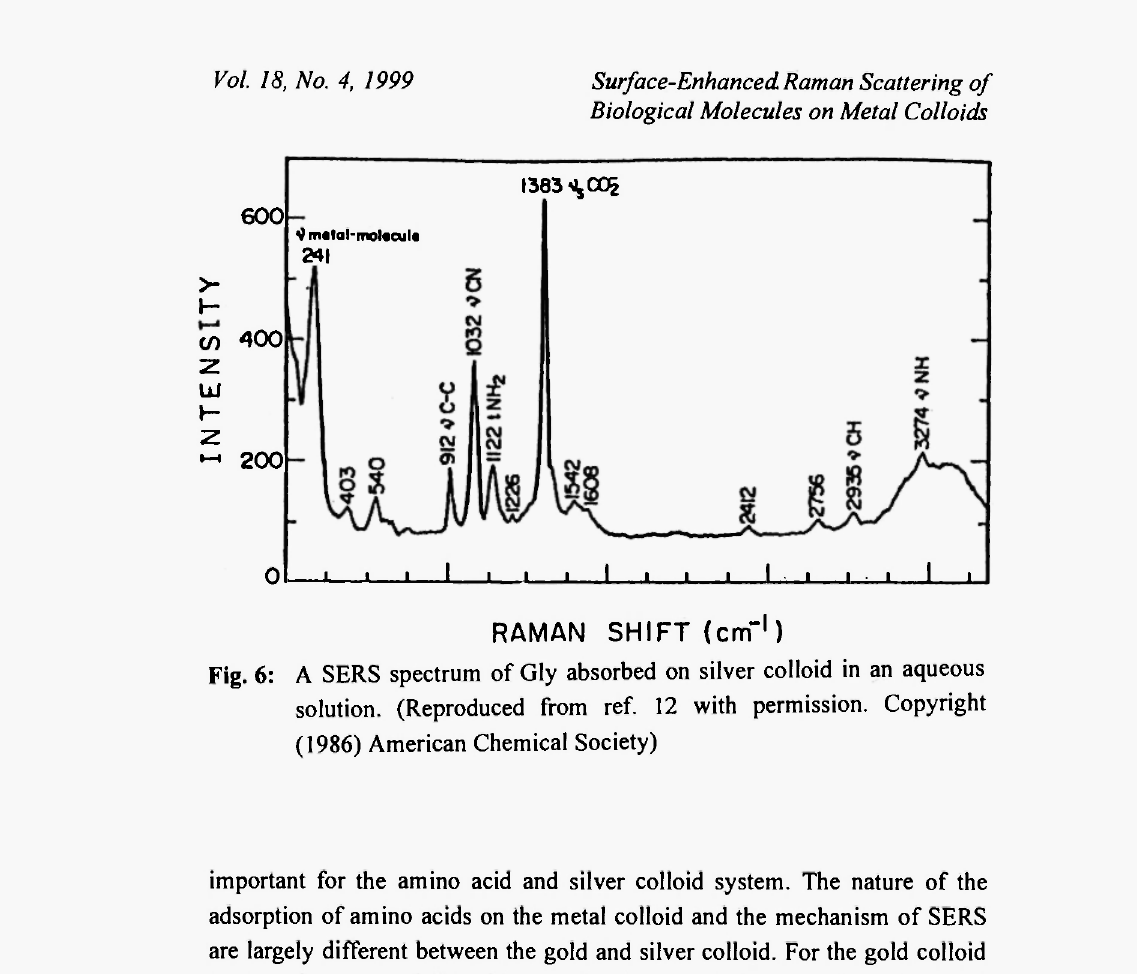
Fig. 6: A SERS spectrum of Gly absorbed on silver colloid in an aqueous solution. (Reproduced from ref. 12 with permission. Copyright (1986) American Chemical